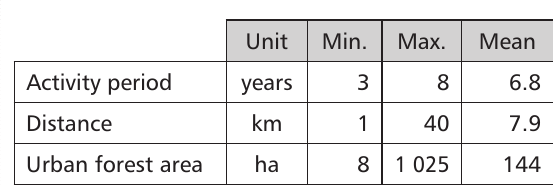
as the average ratio of forest area for 52 settlements